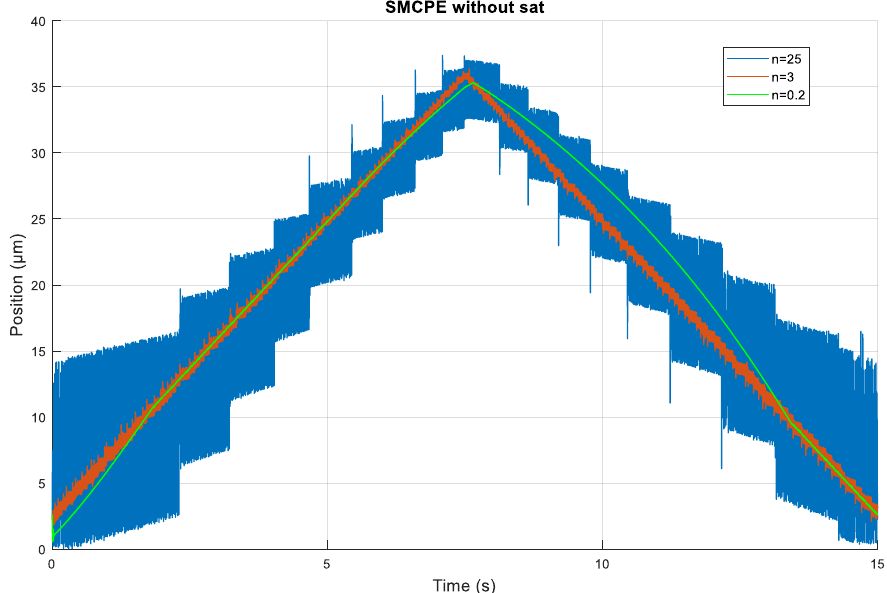
Figure 5. Effect of saturation function in SMCPE controller.